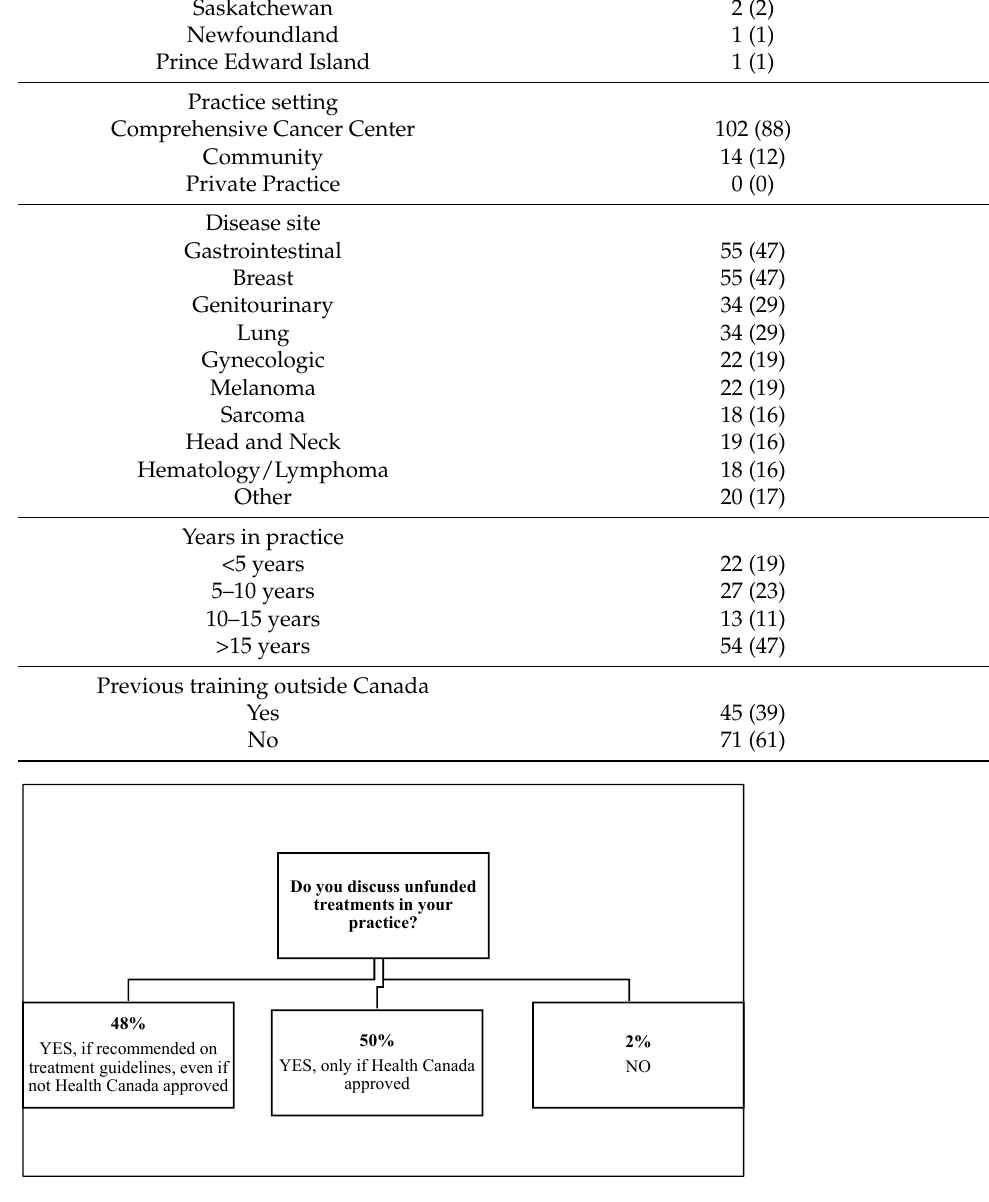
Figure 1. Patterns of practice discussing unfunded treatments among